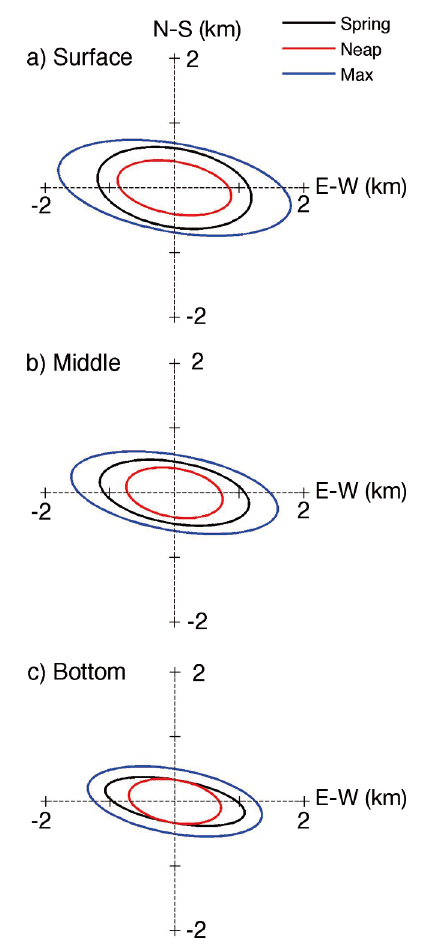
Fig. 9. Semidiurnal tidal excursions ( D x and D y ) at (a) the sur- face, (b) midwater and (c) bottom. In each panel, the black and red ellipses correspond to an average of the semidiurnal tidal currents during spring tides and neap tides, respec- tively. The blue ellipses indicate the tidal excursions calcu- lated with the maximum semidiurnal currents. The horizon- tal axis is oriented in the east−west